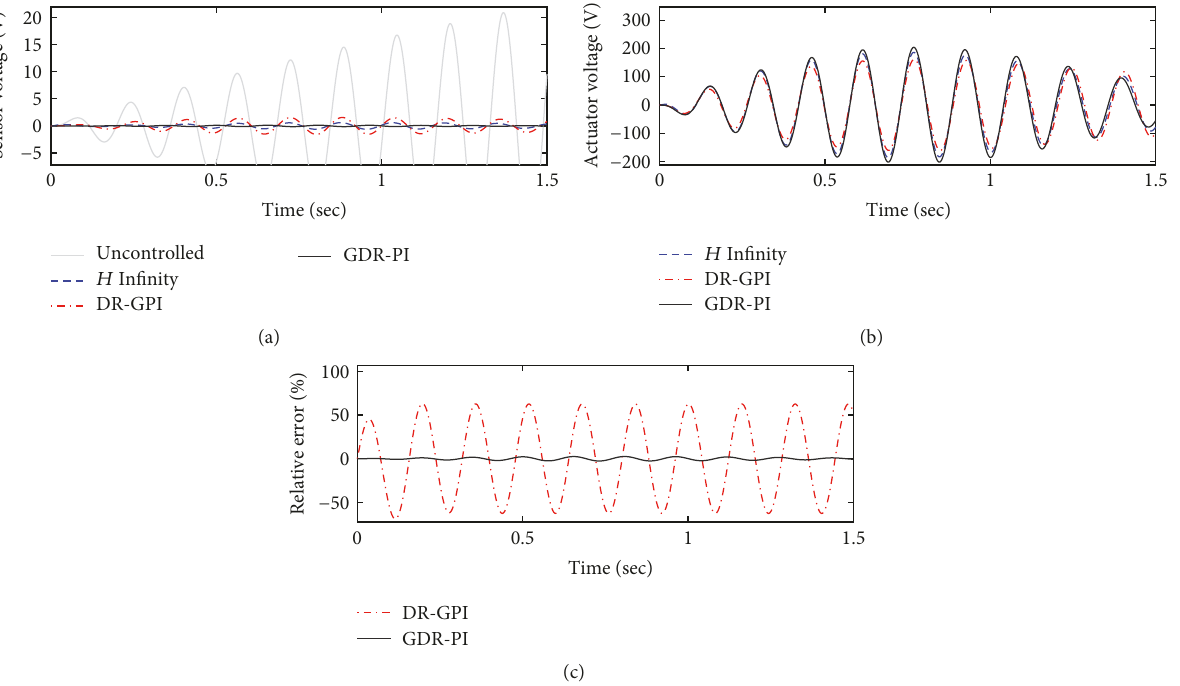
Figure 8: The time domain response of the controlled and uncontrolled smart beam under a harmonic disturbance with the first eigenfrequency (assumed as unknown): (a) sensor output, (b) control input, and (c) relative error of estimated